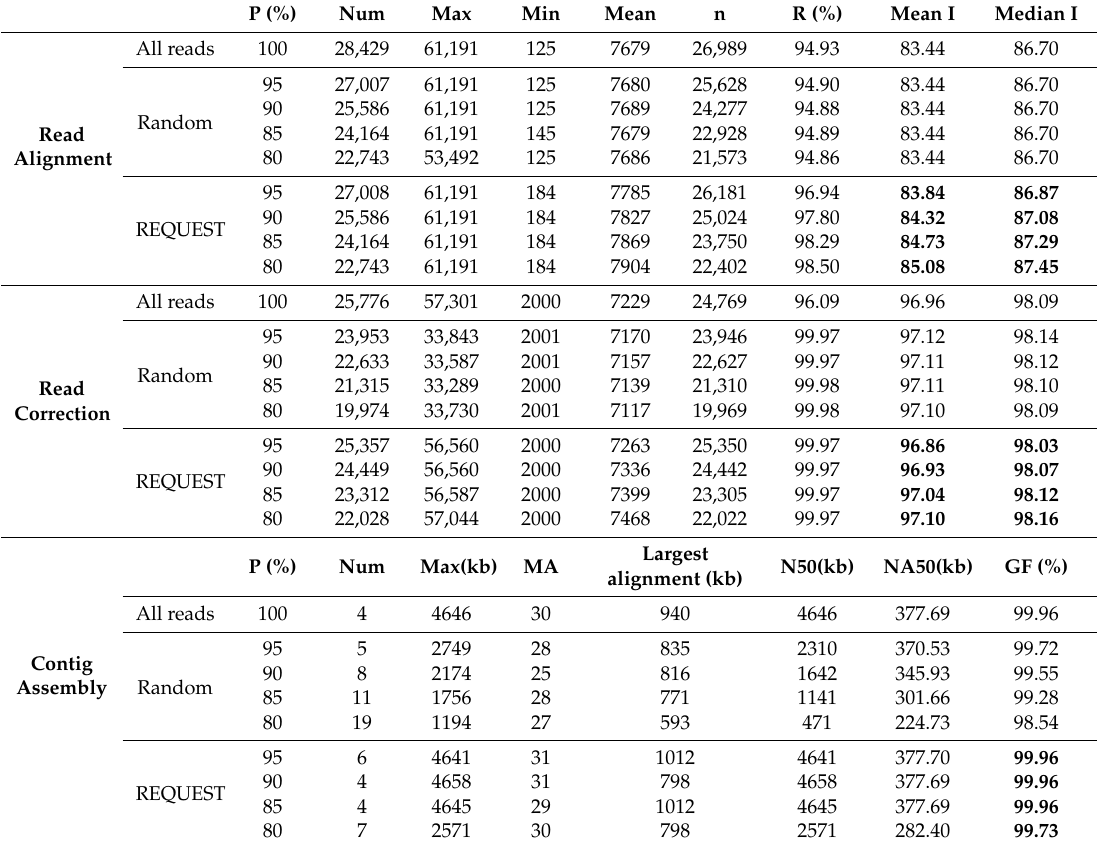
Table 2. Summary of the results of Yersinia pestis in selection, correction, and contigs.